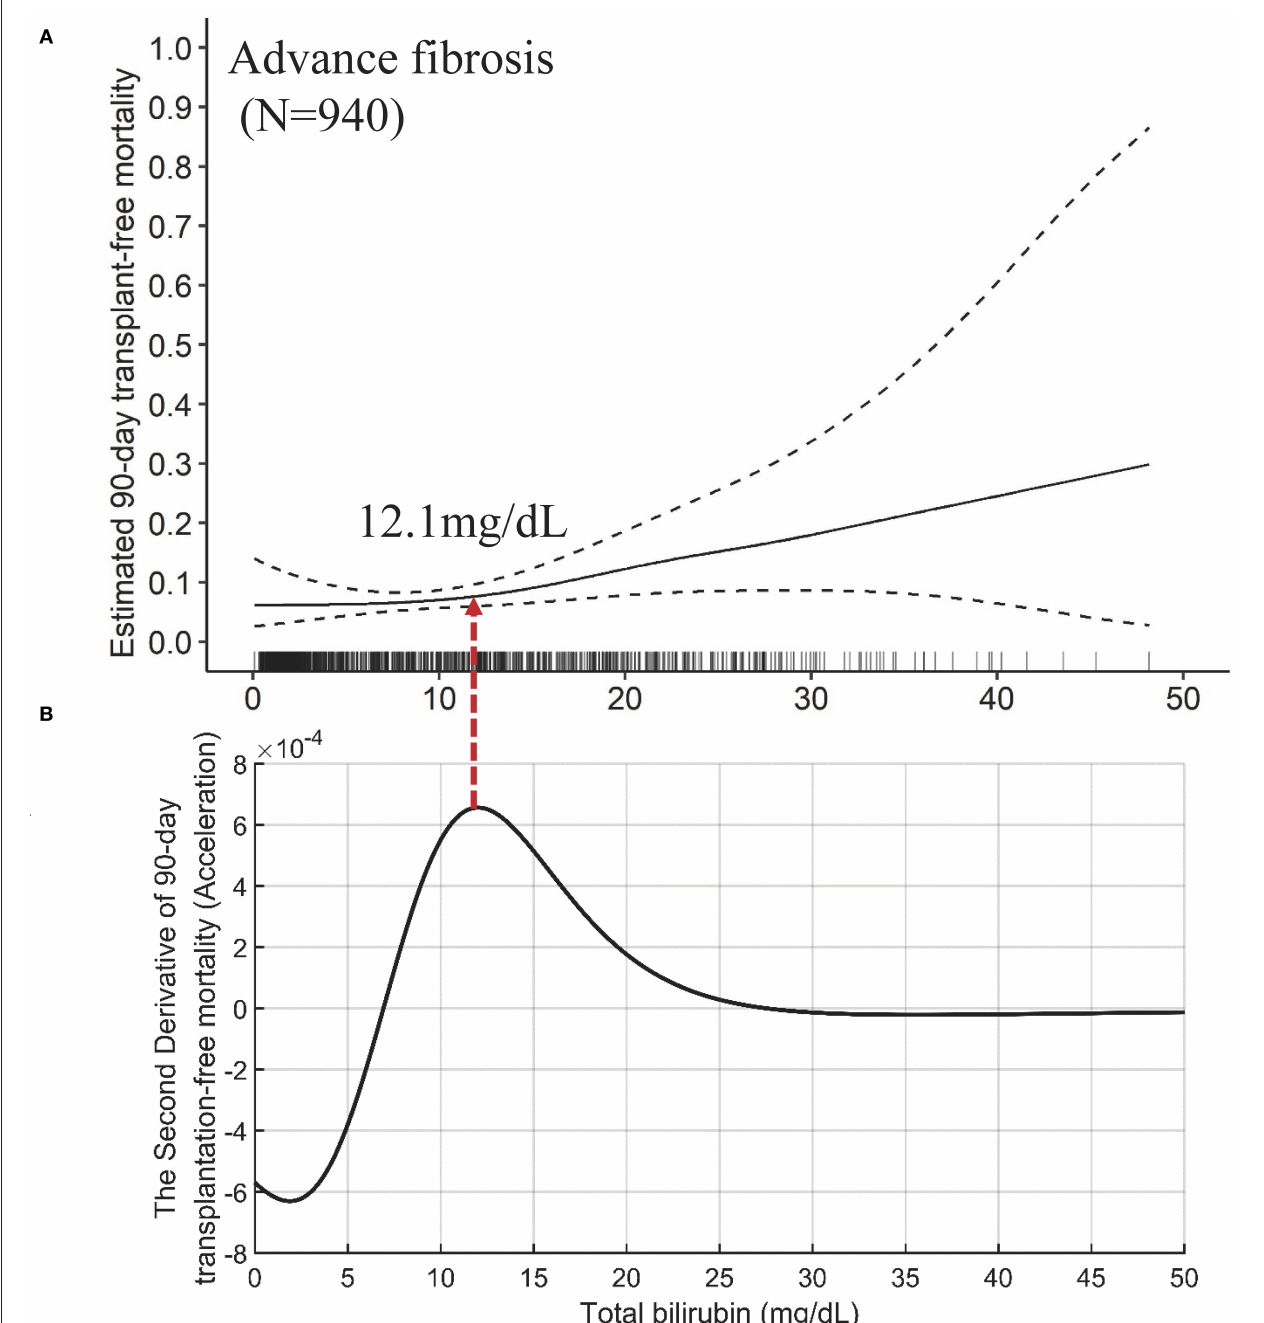
FIGURE 6 | The TB-mortality (90-day) correlation curve of advanced fibrosis and the corresponding second derivative (acceleration) curve. (A) the TB-mortality correlation curve of advanced fibrosis; (B) the second derivative (acceleration) curve of TB to mortality. TB, total bilirubin.